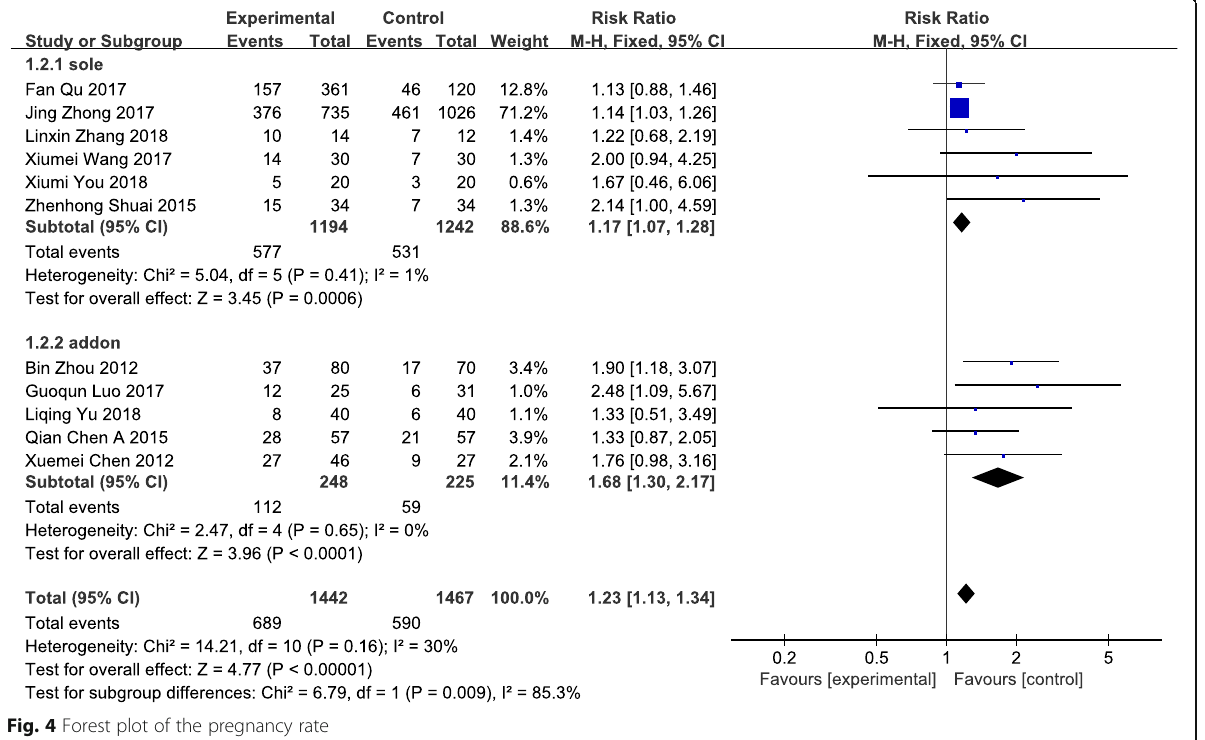
Fig. 4 Forest plot of the pregnancy rate